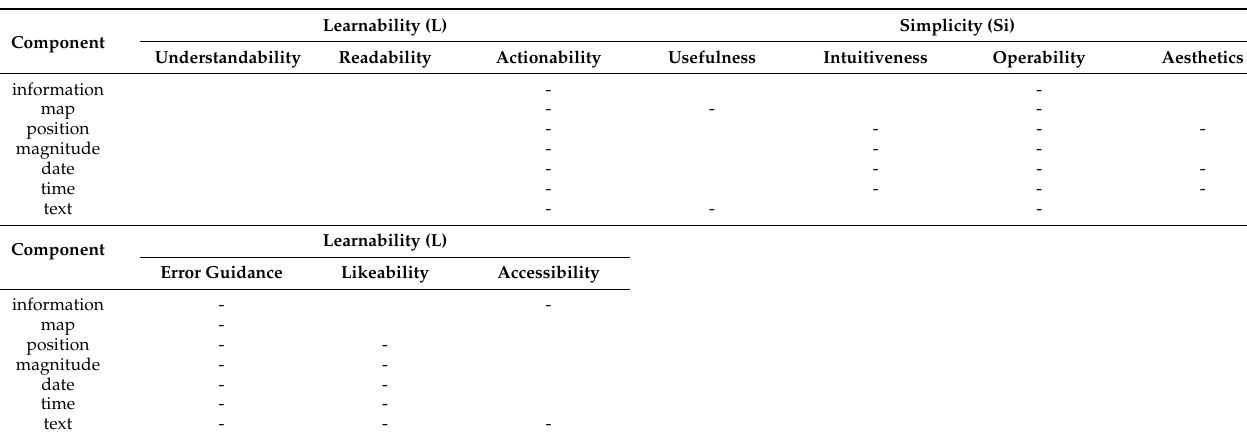
Table 6. The design checklist for UI